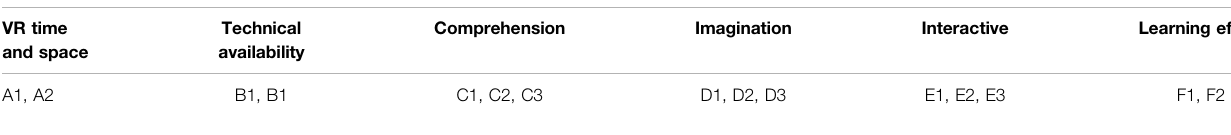
TABLE 4 | Correspondence between variables and